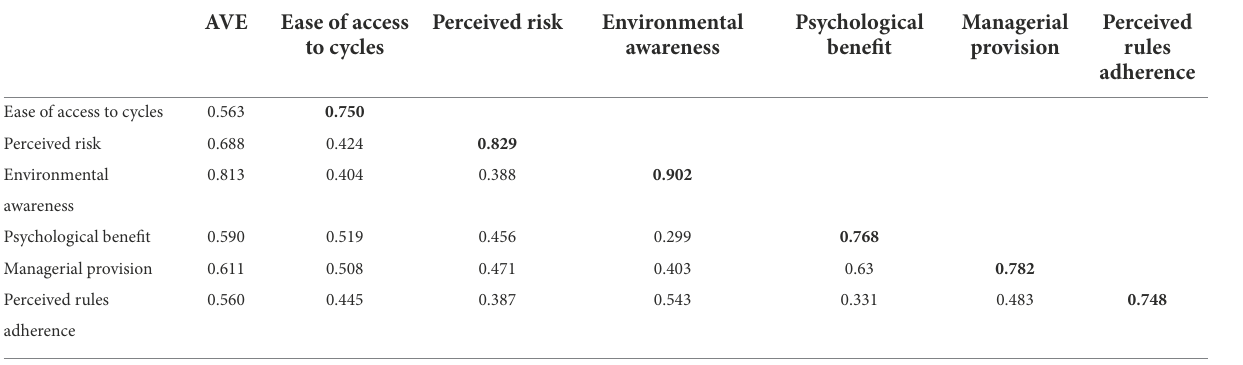
AVE Ease of access Perceived risk Environmental to cycles